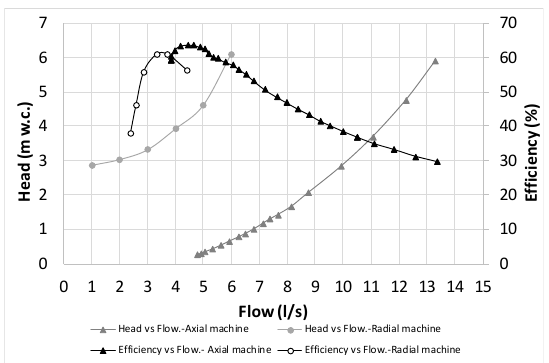
Figure 7. Experimental Head and Efficiency curves of axial ( N 0 = 750 rpm) and radial ( N 0 = 1020 rpm) machines.